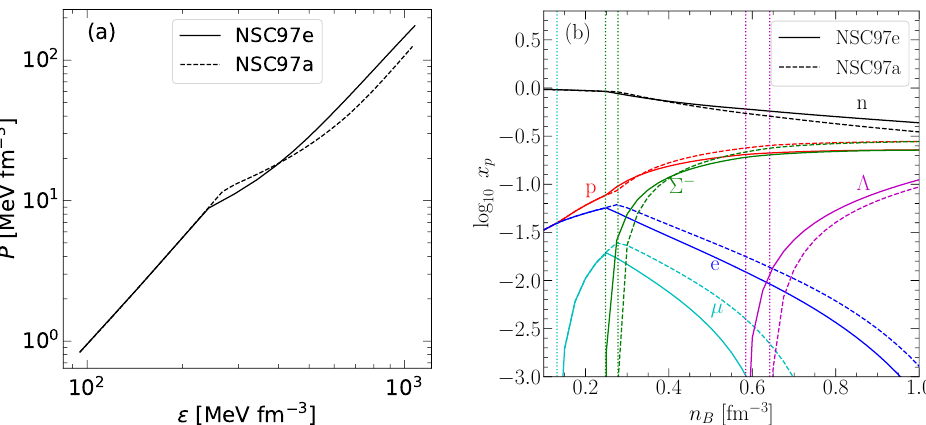
Figure 1. Properties of β -stable hypernuclear matter. Panel ( a ): Pressure as function of a total energy density for the NSC97e (solid lines) and NSC97a (dashed lines) models. Panel ( b ): Particle fractions as a function of total baryon number density for the NSC97e (solid lines) and NSC97a (dashed lines) models. Vertical dashed lines indicate µ , Σ − , and Λ thresholds.